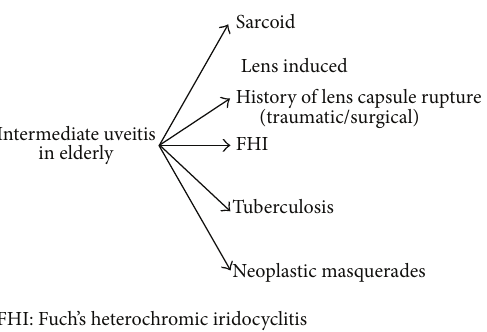
Figure 2: Differential diagnosis of intermediate uveitis in elderly patients. FHI: Fuch’s heterochromic